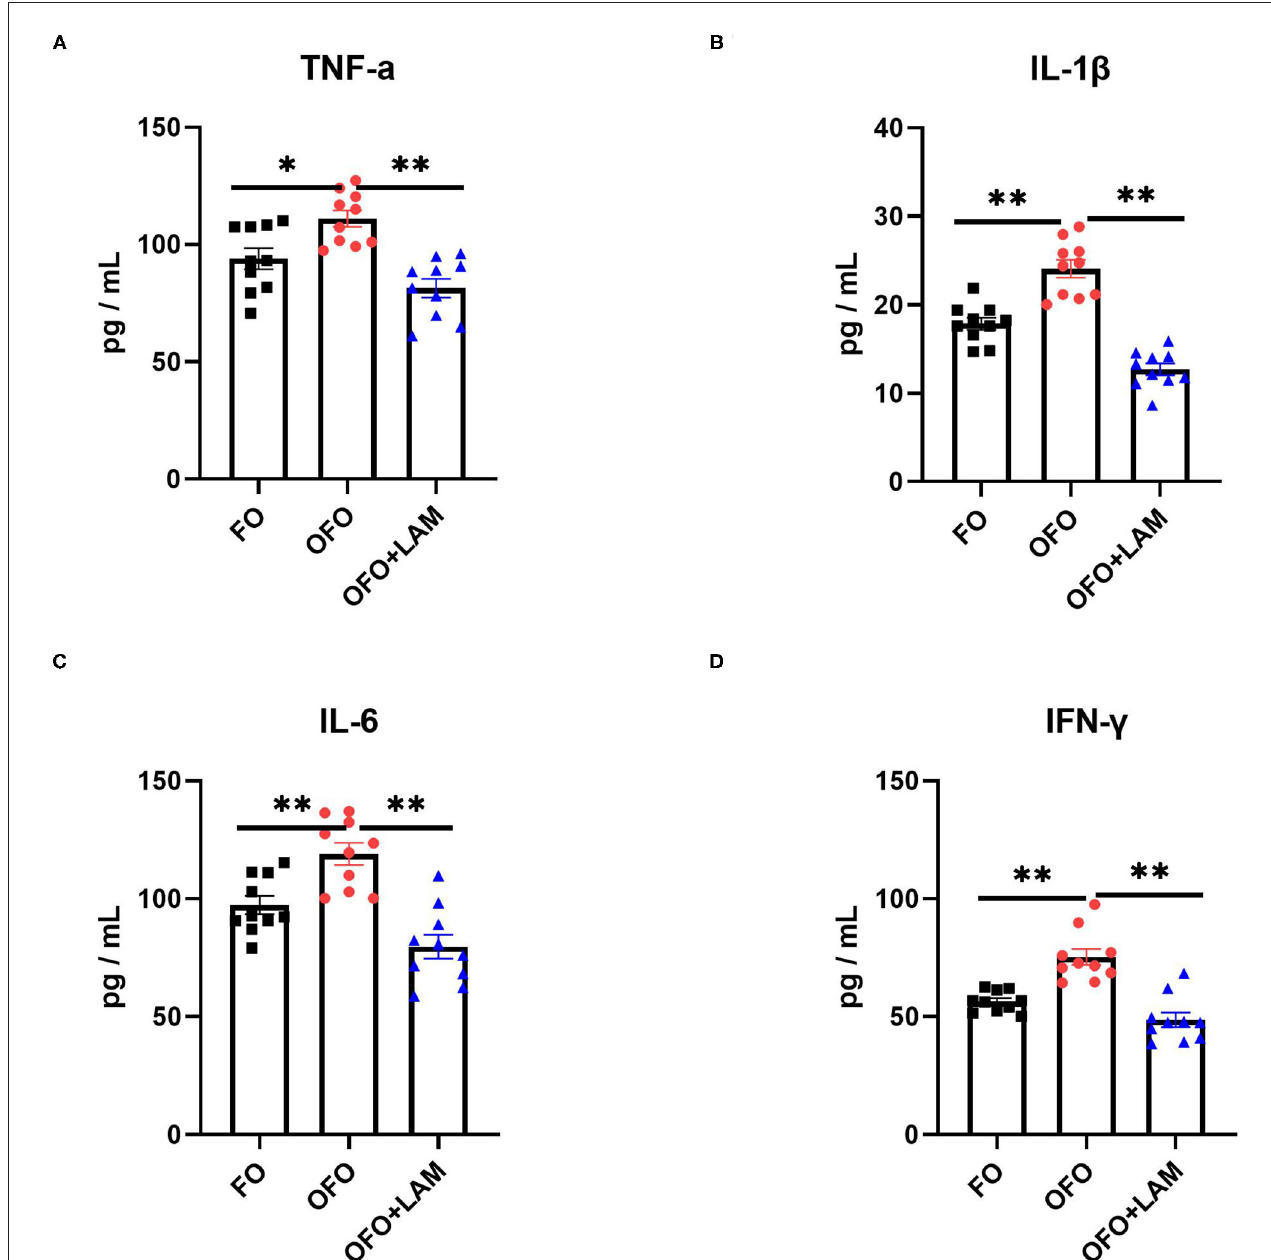
FIGURE 2 | The effect of FO, OFO, and OFO with LAM on serum inflammatory cytokines. (A) Content of tumor necrosis factor α (TNF- α ) in FO, OFO, and OFO + LAM. (B) Content of interleukin 1 β (IL-1 β ) in FO, OFO, and OFO + LAM. (C) Content of interleukin 6 (IL-6) in FO, OFO, and OFO + LAM. (D) Content of interferon γ (IFN- γ ) in FO, OFO, and OFO + LAM. ** p < 0.01 and * p < 0.05 indicate significant differences between two